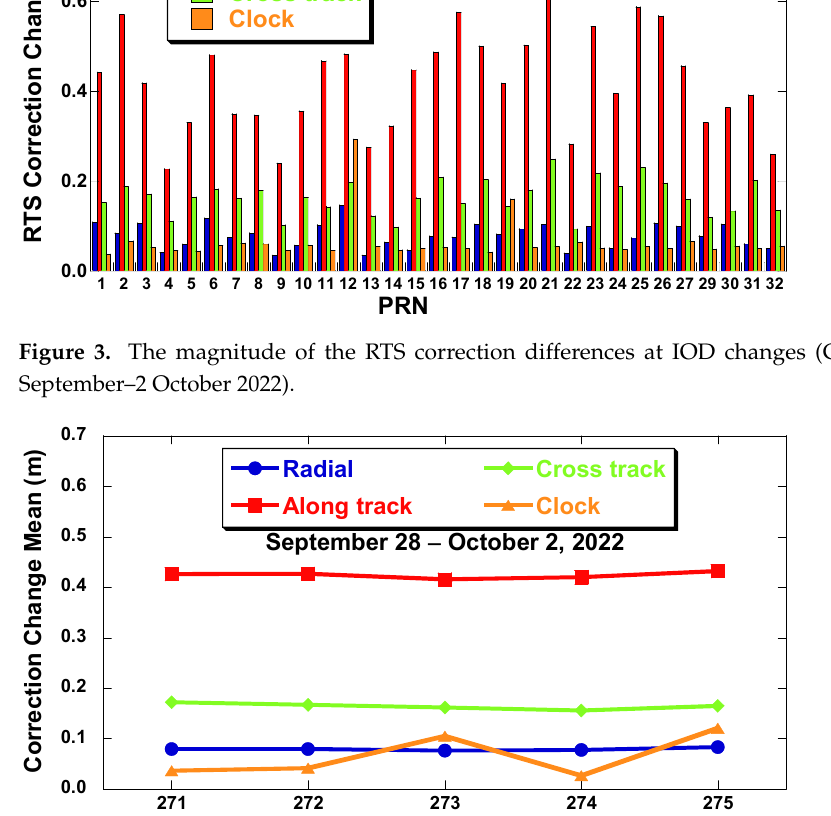
Figure 4. Daily magnitude of the RTS correction difference at IOD changes (GPS satellites, 28 September–2 October 2022).